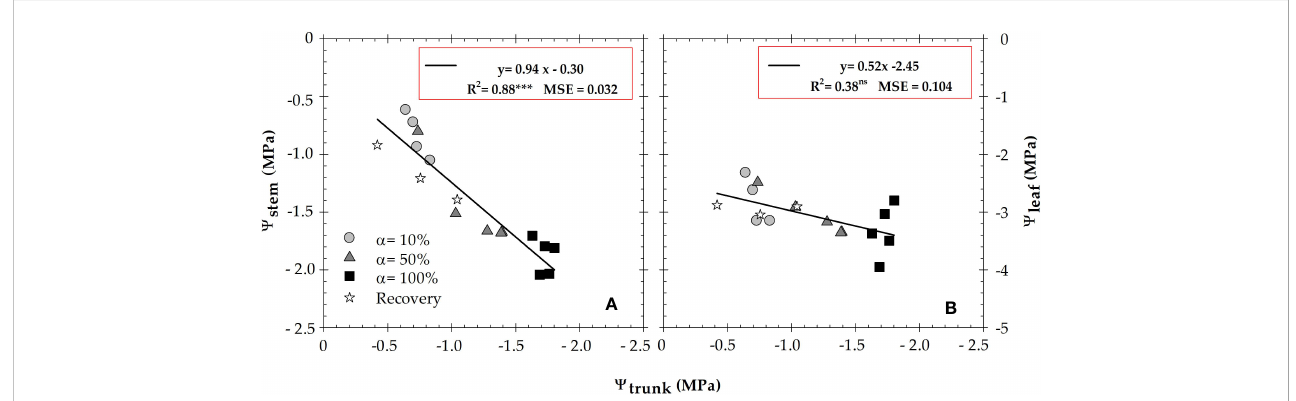
FIGURE 4 Relationship between midday values of trunk water potential ( Y trunk ) and (A) stem water potential ( Y stem ), and (B) leaf water potential ( Y leaf ), during the experimental period. The different symbols correspond to the different irrigation criteria. Each point is the mean of four leaves and two matrix sensors. R 2 is the coef fi cient of determination. ***: p ≤ 0.001, ns: not signi fi cant. MSE: mean squared